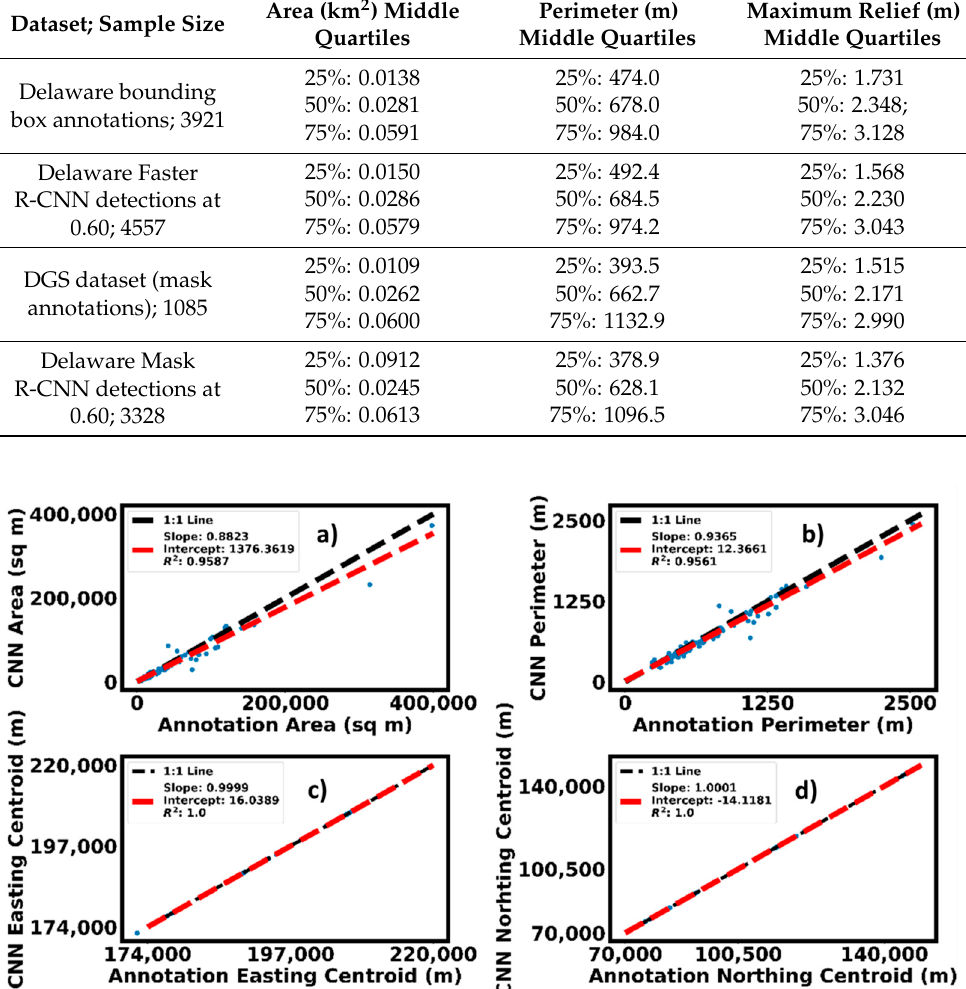
Figure 11. Delaware’s Carolina Bay detection counts at 60% threshold for various DEM tile sizes and overlap amounts compared to the annotation count.